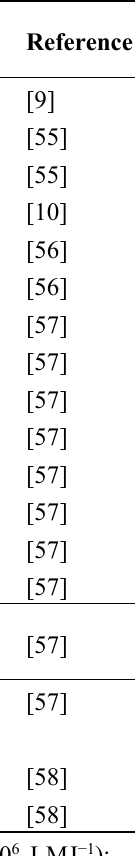
Table 4. Factors for estimation of emissions from pig and crop production in three organic pig production